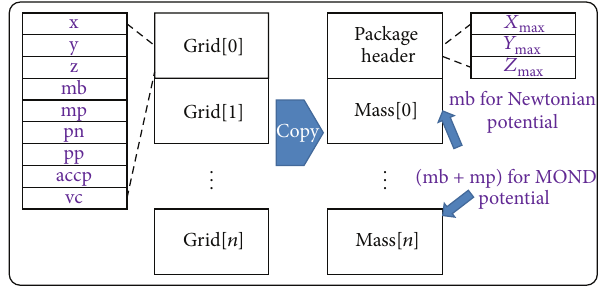
Figure 7: Illustration of memory copy